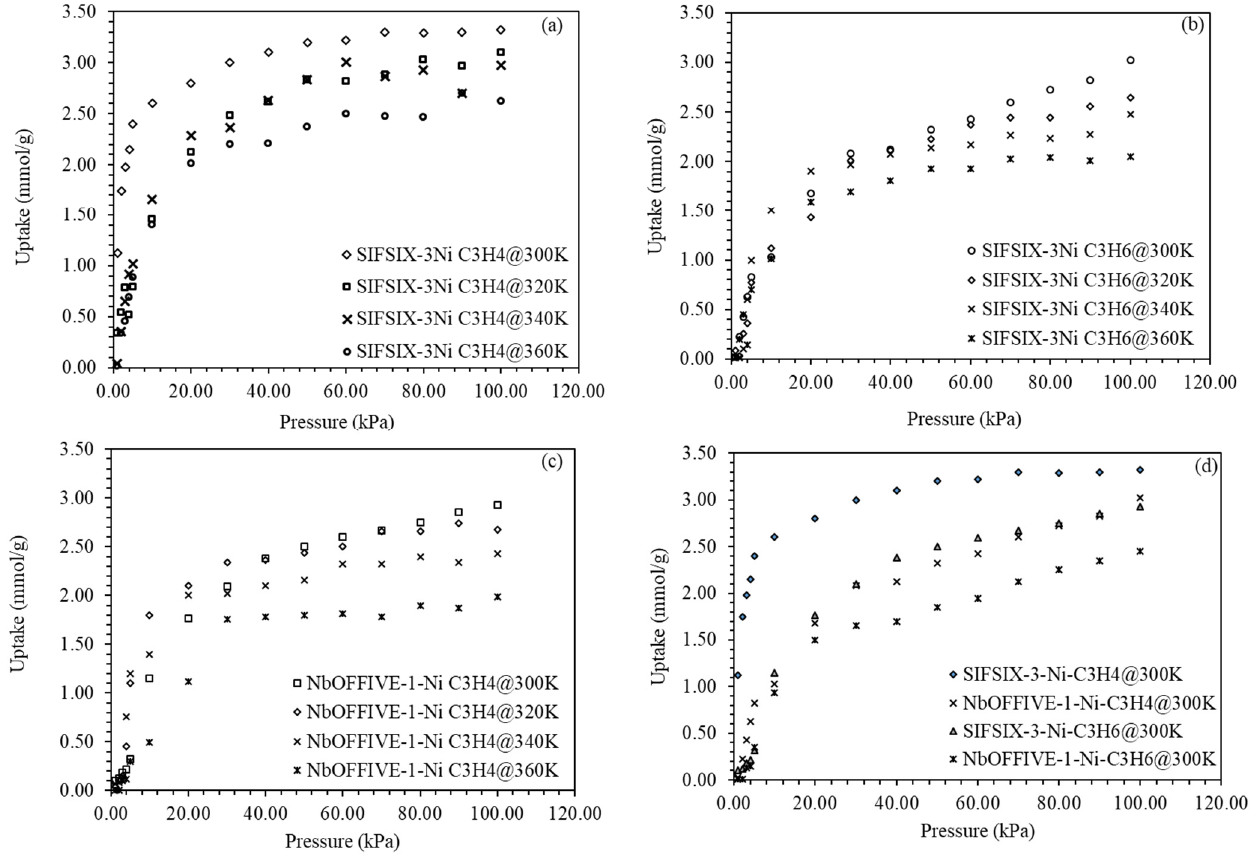
Figure 4. Full experimental isotherms at different temperatures (300–360 K) ( a ) C 3 H 4 and SIFSIX-3-Ni ( b ) C 3 H 6 and SIFSIX-3-Ni ( c ) C 3 H 4 and NbOFFIVE-1-Ni ( d ) C 3 H 6 and NbOFFIVE-1-Ni. Table 2. Uptake adsorption values reported in the